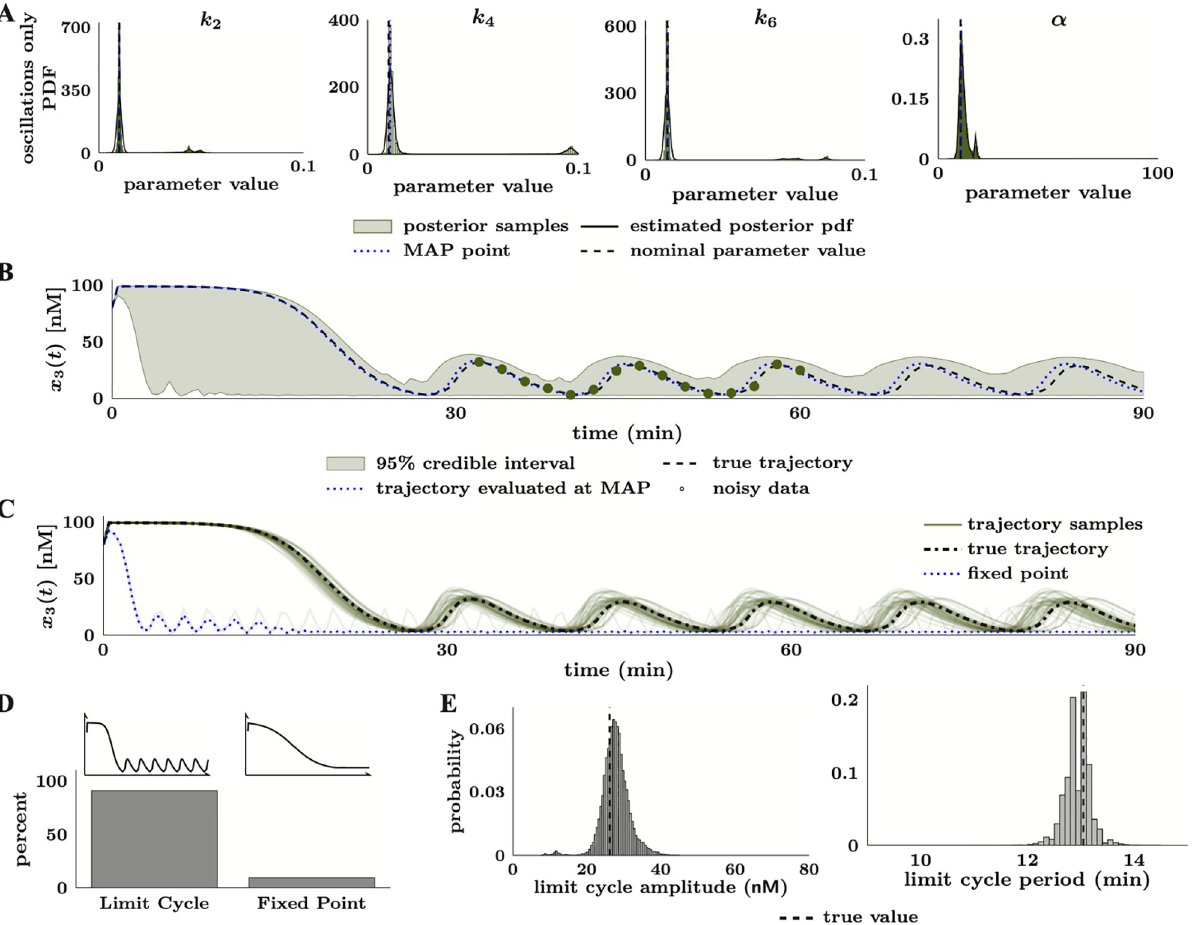
Fig 6. Parameter estimation results for the MAPK model in the limit cycle regime with data only sampled from the oscillations. ( A ) Marginal posterior distributions of the model parameters. Distributions are visualized by fitting a kernel density estimator to 1,305,720 (30 walkers with 43,524 steps each) MCMC samples obtained using CIUKF-MCMC with the affine invariant ensemble sampler (AIES) after discarding the first 7,447 samples per walker as burn-in. ( B ) Posterior distribution of the trajectory of x 3 ( t ) in the limit cycle regime. The true trajectory (dashed black line) shows the dynamics with the nominal parameters, the dotted blue line shows the trajectory evaluated at the MAP point, and the points show the noisy data (covariance is 1% of the variance of the true trajectory). The 95% credible interval shows the region between the 2.5th and 97.5th percentiles that contains 95% of 30,000 posterior trajectories. ( C ) Sample posterior trajectories (50 out of 30,000 total) reveal that most trajectories closely match the true limit cycles. Additionally, several trajectories that reach a fixed point are shown. ( D ) Quantification of the fraction of the 30,000 sample trajectories that produce limit cycles oscillations, 90.6% (27,182 samples), or reach a fixed point, 9.4% (2,818 samples). ( E ) Histograms quantify the variability in limit cycle amplitude and period for the 27,182 trajectories that show limit cycle oscillations. We define the limit cycle amplitude as the peak-to-peak difference for one oscillation, and the period is the time to complete an oscillation. The vertical black lines show these quantities for the true trajectory.